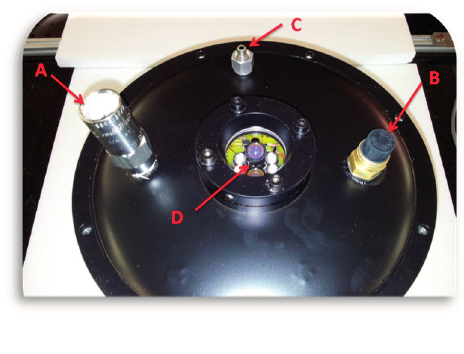
Figure 4. View of the chamber cover: A—safety pressure valve; B—electrical connector; C—gas inlet; D—quartz glass window covering the LEDs and the spectrometer.